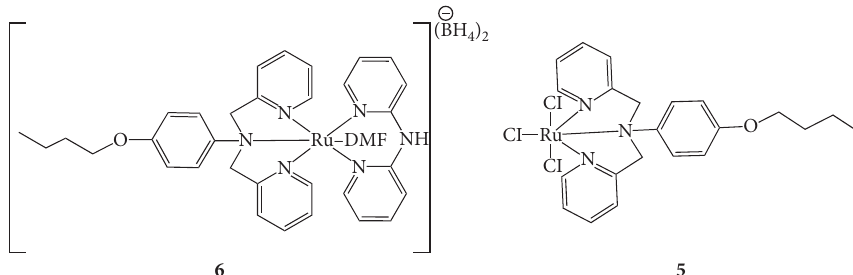
Figure 4: The mononuclear ruthenium (II/III) complexes reported in our previous work [6]. The difference with these analogues is that the complexes ( 3 and 4 ) in this paper are bridged by a four-member aliphatic chain. The chain in the mononuclear complexes does not connect to anything.